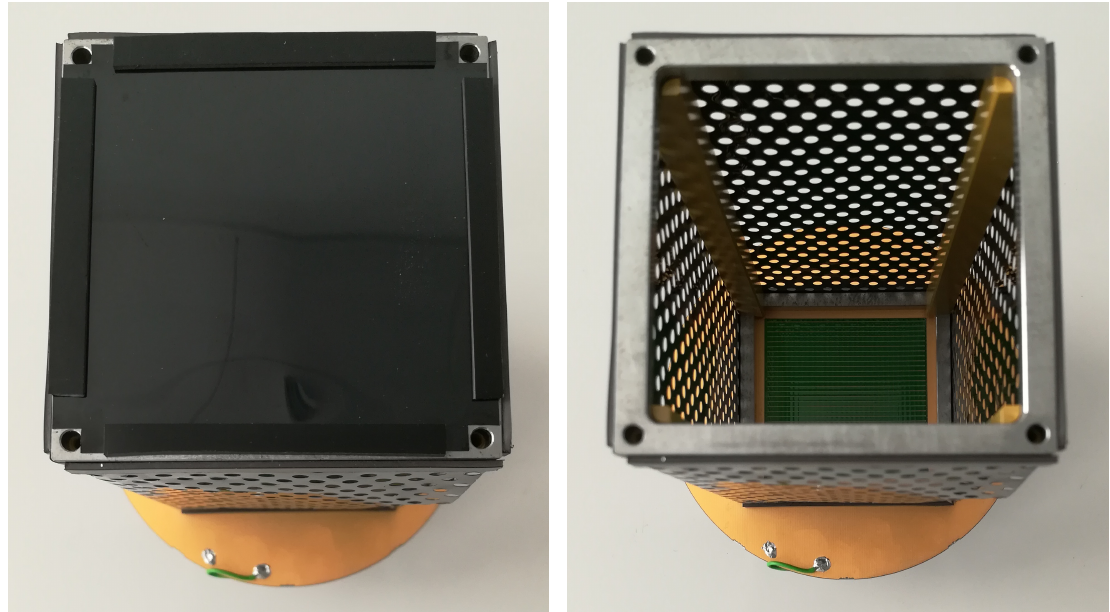
Figure 3. Resistive shell TPC mockup with and without the attached cathode plane. The resistive foil is mounted with magnet stripes to the grey frames, both of them 5mm thick.